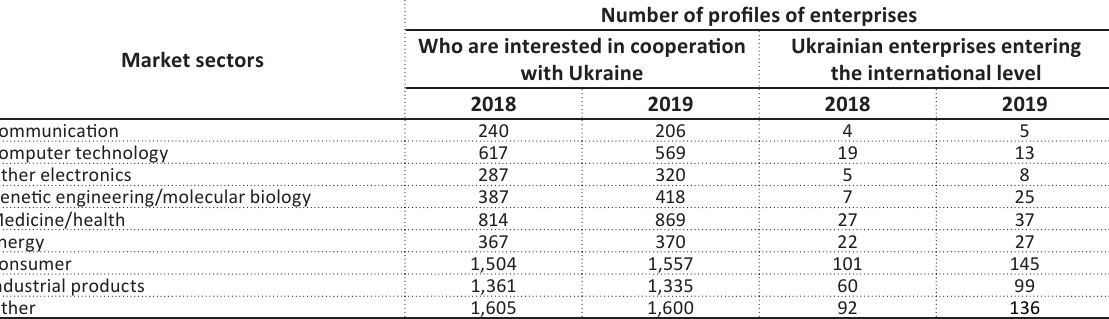
Table 1. Number of profiles of potential counterparties by market sector in the EEN system for 2018 – first half of 2019